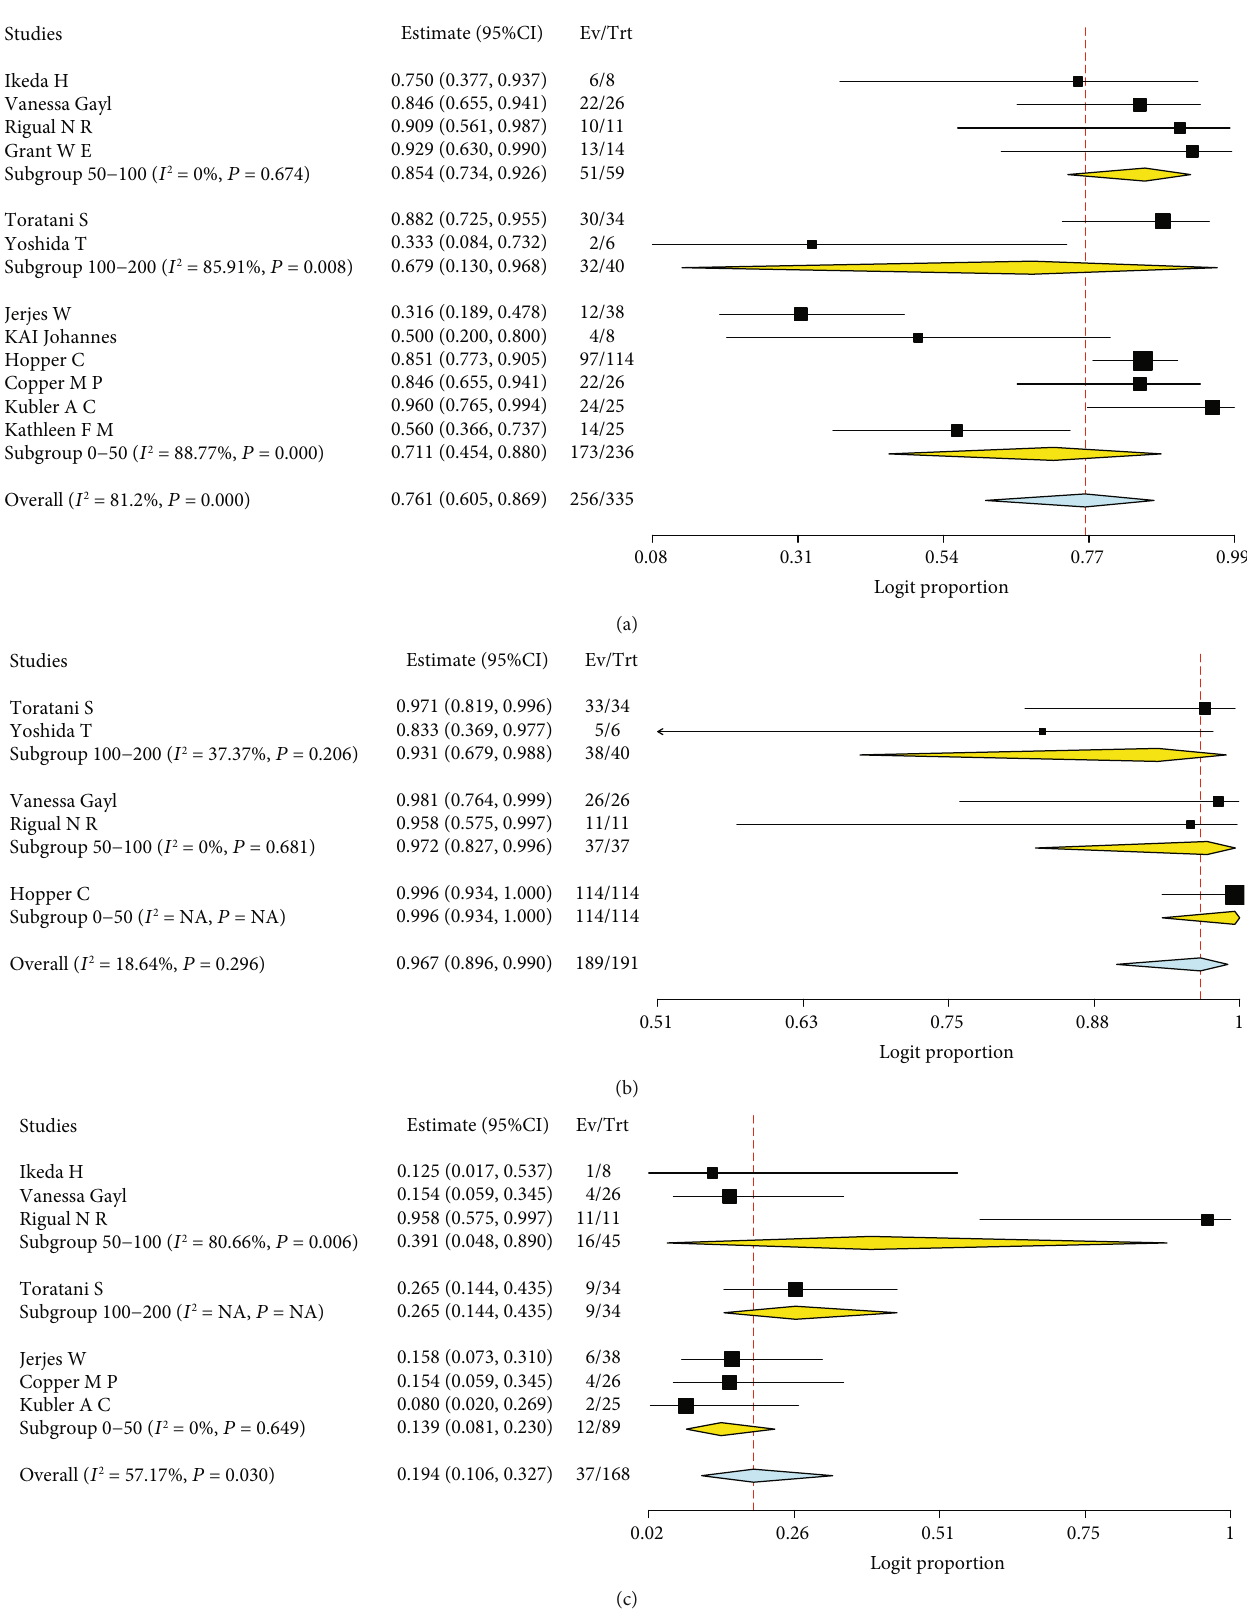
Figure 8: Forest plot of subgroup analysis of (a) CR, (b) OR, and (c) RR in cases about di ff erent radiant